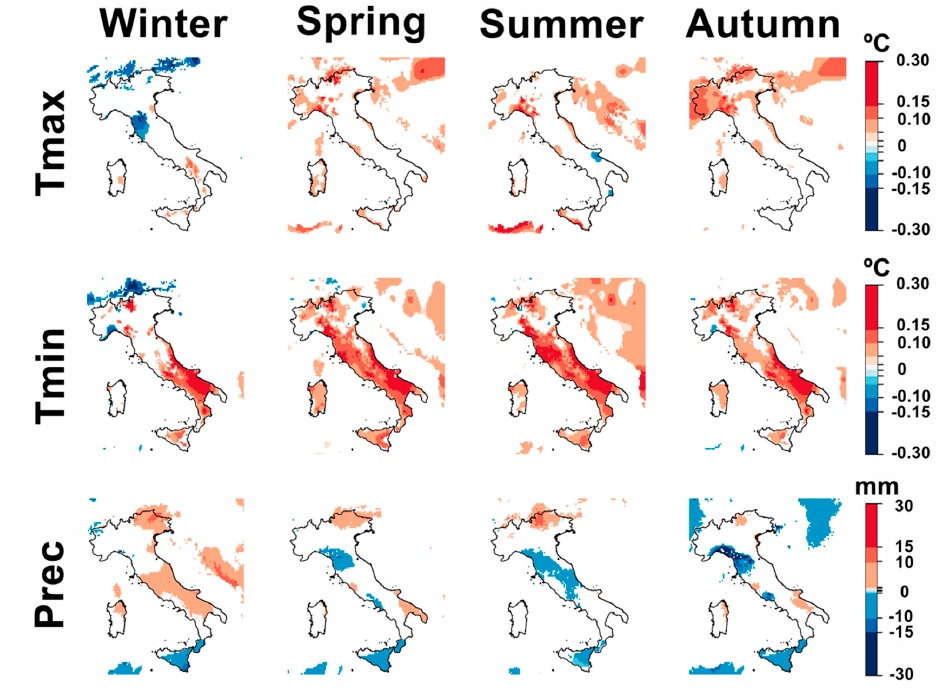
Figure 2. Trends of climatic variables in Italy (Tmax, maximum temperature; Tmin, minimum temperature; Prec, accumulated precipitation). The colors represent significant slopes of regression for the trends (significance level 95%). Trends were calculated using seasonal periods: Winter,